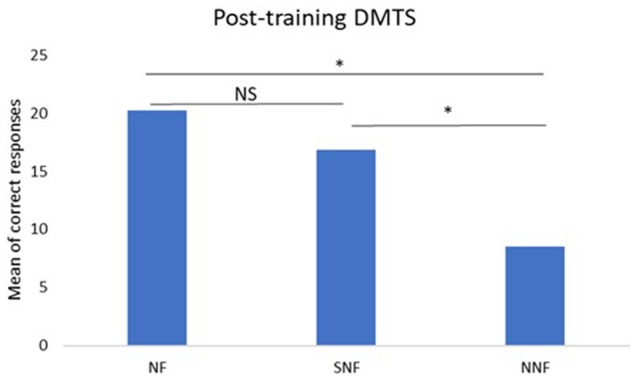
Mean number of correct responses in the post-training DMTS test. ANOVA and post hoc Bonferroni tests indicate significant differences between NF and NNF groups, and between SNF and NNF groups, but not between NF and SNF groups. *Significant difference; NS, No Significance.